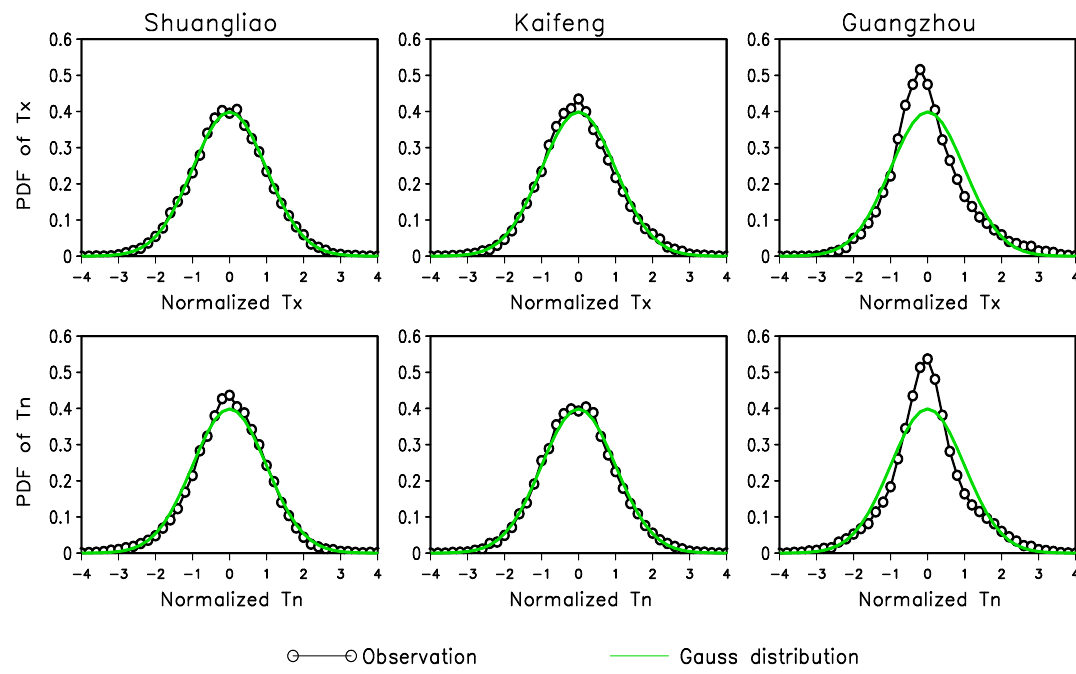
Fig. 2 Probability density function (PDF) of the normalized daily maximum (Tx: Top panel) and minimum temperature (Tn: Bottom panel) for three selected stations,